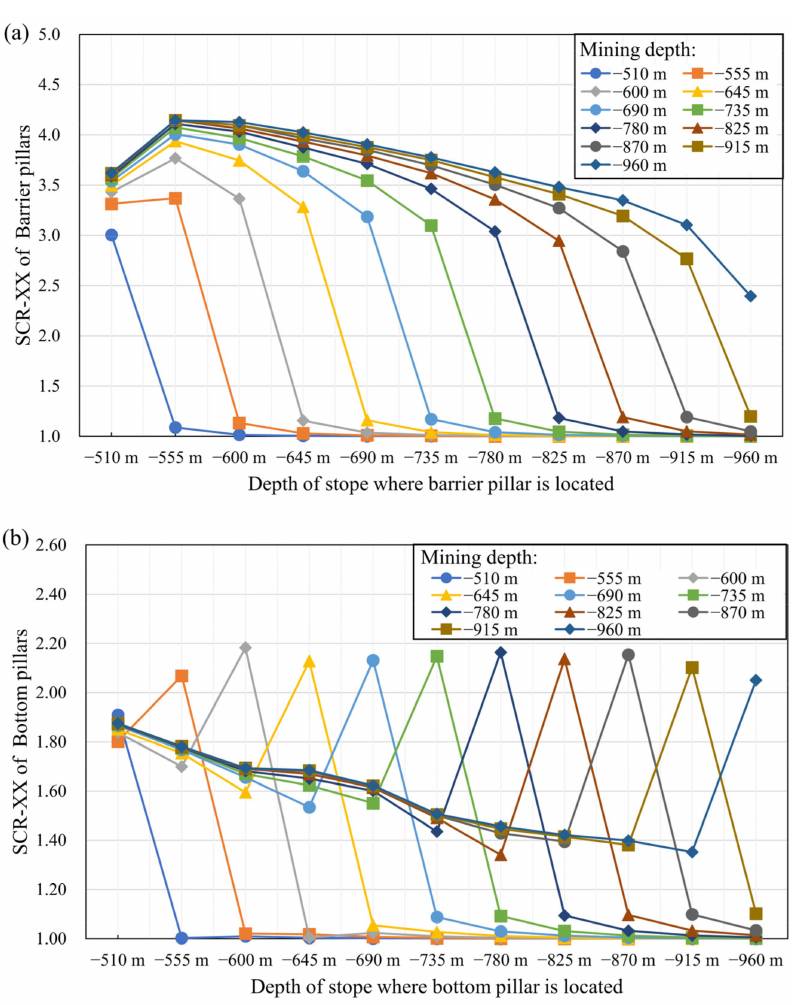
Figure 11. SCR-XX curves of ( a ) barrier pillars and ( b ) bottom pillars at different depths after excavation of stopes at different